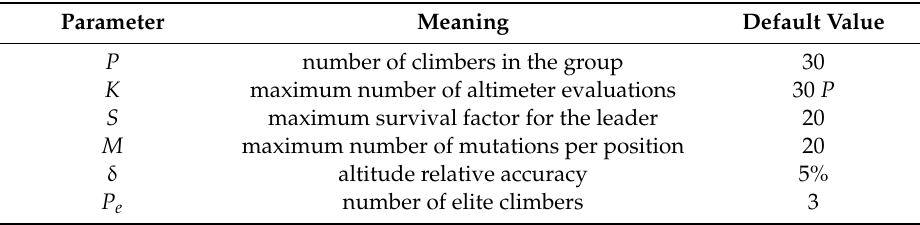
Table 1. Configuring parameters of